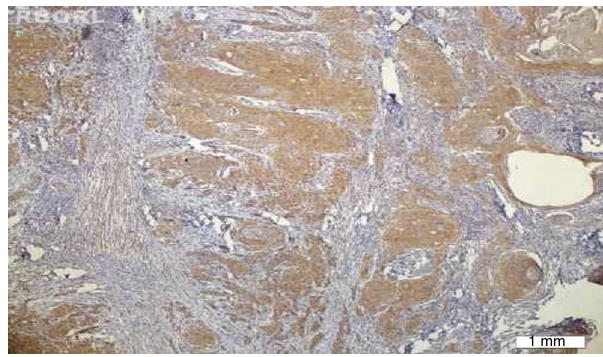
Cytoplasmic staining of vascular endothelial growth factor in squamous cell carcinoma (200 × ).